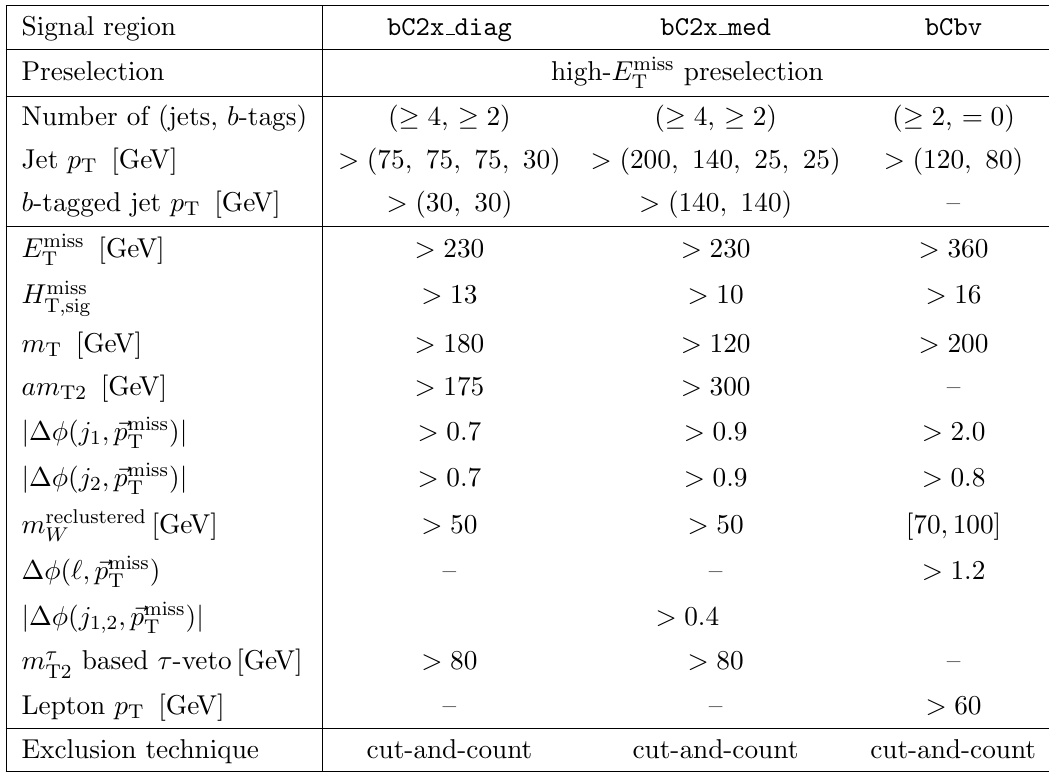
Table 9 . Overview of the event selections for the bC2x med , bC2x diag , and bCbv SRs. List values are provided in between parentheses and square brackets denote